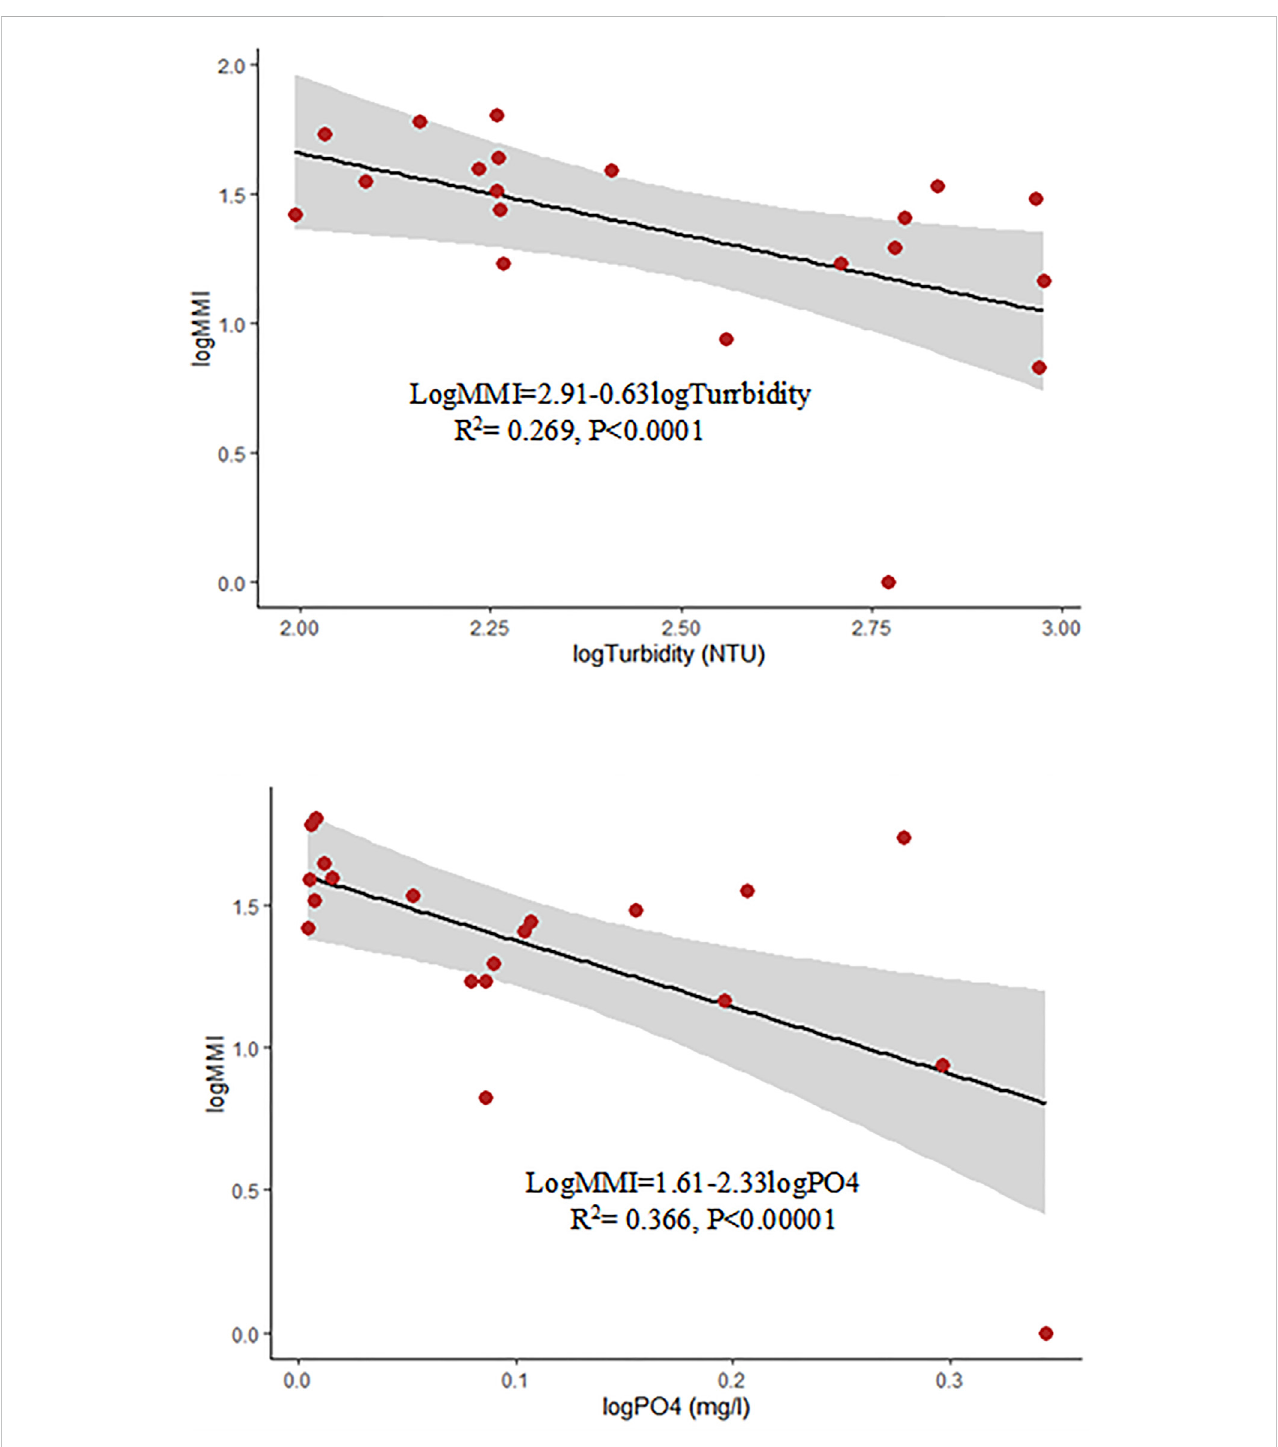
FIGURE 3 Regression models showing the relationships between MMI and the concentration of turbidity and PO 4 3 −